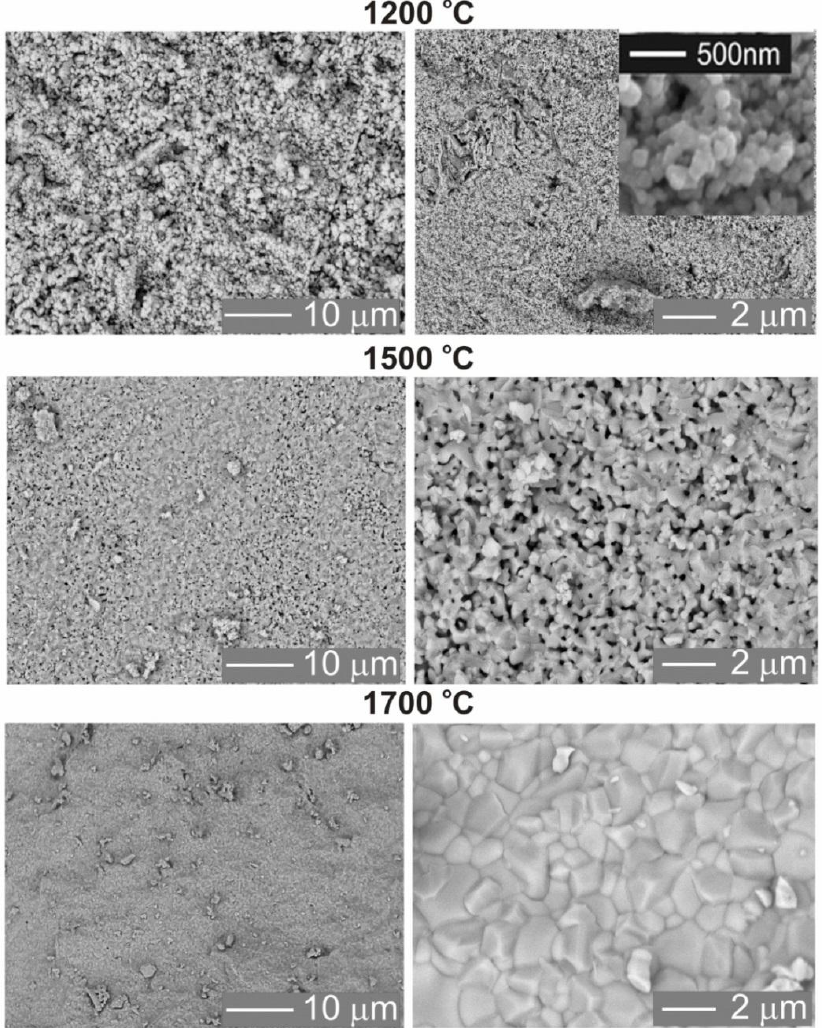
O :0.05%Pr,0.1%Hf ceramics annealed in a 2 3